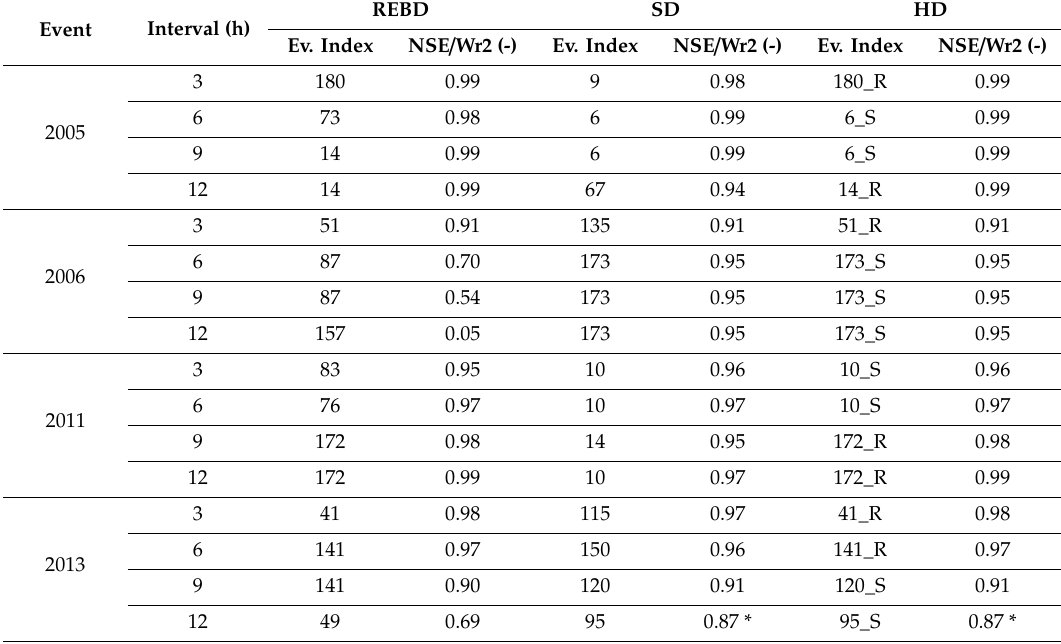
Table 2. NSE / Wr2 goodness of fit and index of the selected event from the REBD, SD, and HD for the four validation events of 2005, 2006, 2011, and 2013.